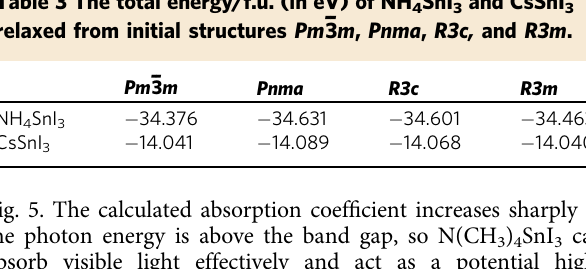
Pm-- 3 m , Pnma , R3c, and R3m